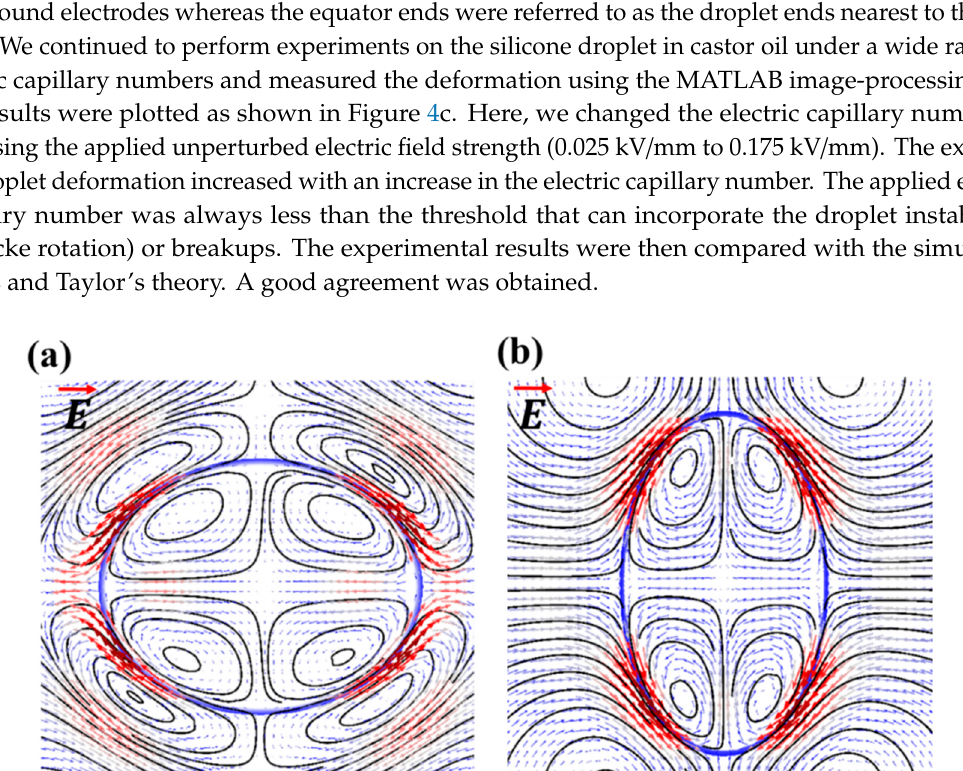
Figure 4. Experimental results for the particle-free droplet deformation: ( a ) the oblate deformation; SC system, ( b ) the prolate deformation; CS system, ( c ) the comparison with the simulation/experimental results and Taylor’s theory [6]. The electric capillary number was changed by increasing the electric field strength in a range from 0.025 kV/mm to 0.175 kV/mm. The radius of the droplet was fixed as 1 mm. In the case of suspensions for which S > R holds, the particles were driven to the interface by applying weak electric field pulses ( E o ~ 0.1 kV mm − 1 ) for about 2 min. By doing so, the electrohydrodynamic flow inside the droplet pushed the particles towards the interface. These particles were then dragged by the flow at the interface towards the equator. Once entrapped at the interface, the electric field was removed. The particle distribution was then randomized at the interface and particle-covered droplets were produced. The schematic of the whole process is as shown in Figure 5, while the experimental image of a produced particle-covered droplet is shown in Figure 6a. It was found that suspensions for which S < R, the particles seemed unaffected by the